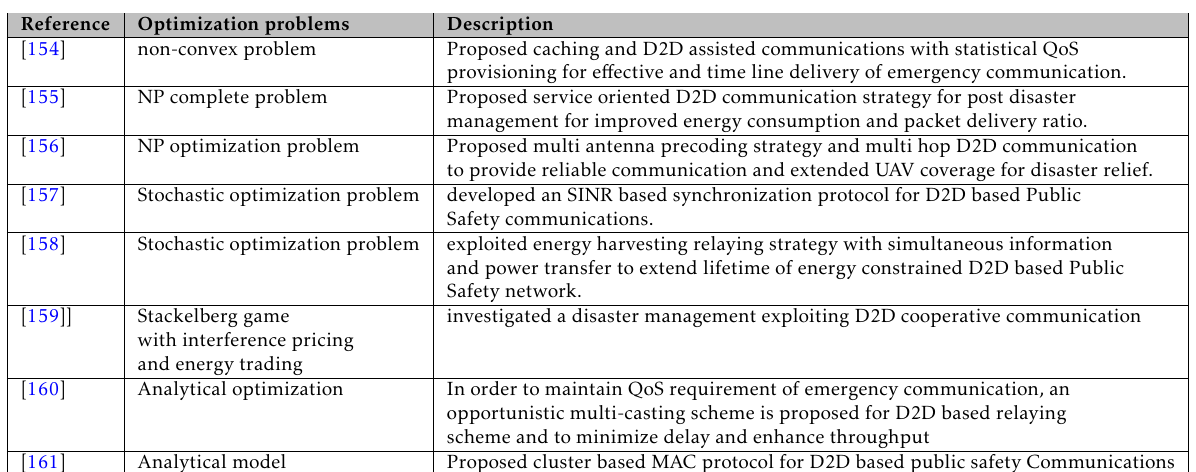
Table 8. Resource Optimization for D2D-based Public Safety Communication